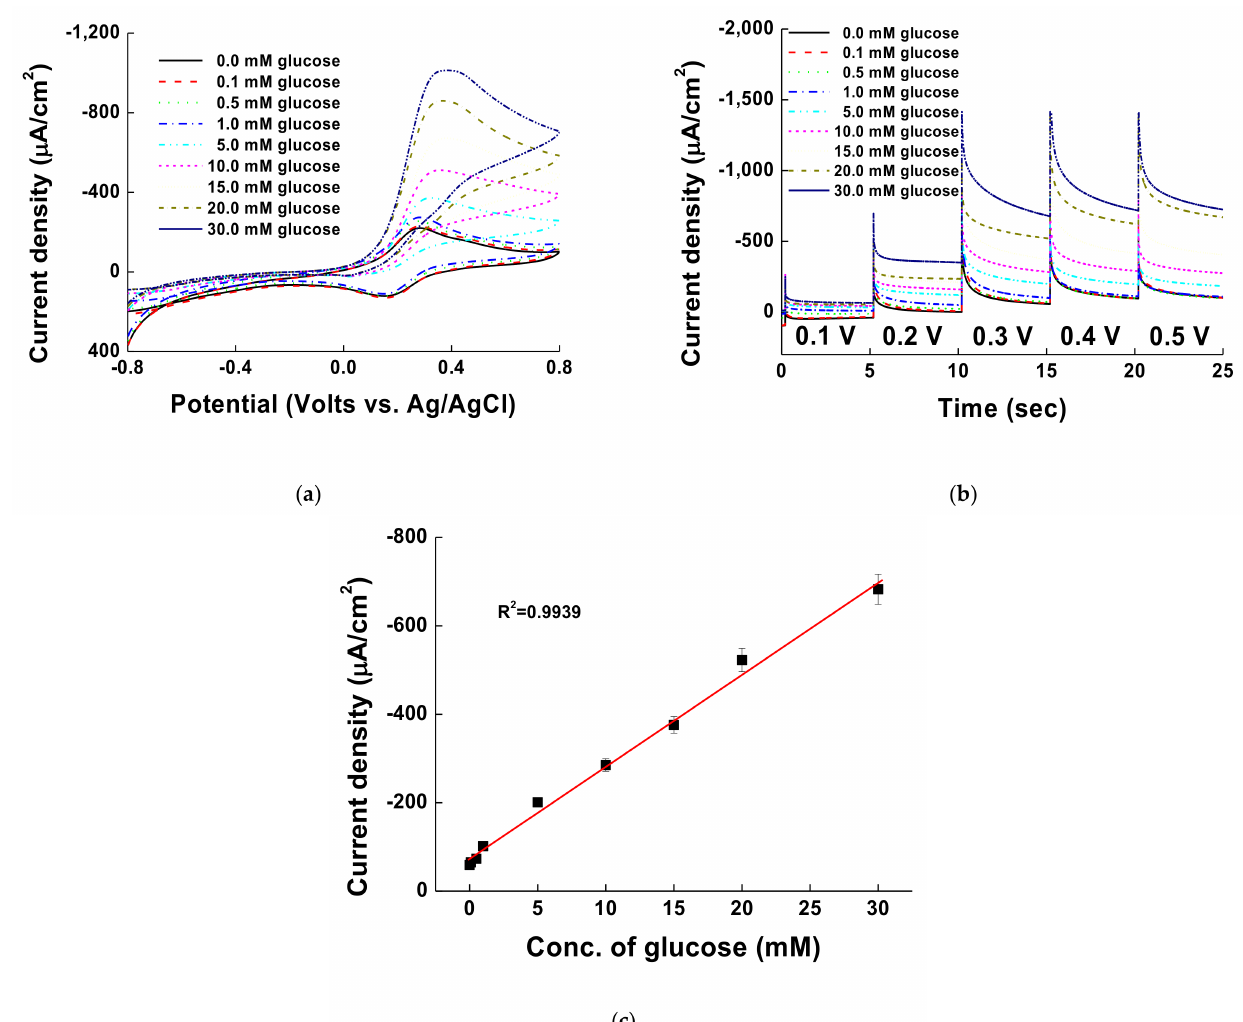
Figure 5. ( a ) Cyclic voltammograms and ( b ) multi-potential step (MPS) results of measuring glucose at concentrations of 0.0, 0.1, 0.5, 1.0, 5.0, 10.0, 15.0, 20.0, and 30.0 mM in PBS (pH 7.0). ( c ) Calibration curve of glucose concentration from 0.0 to 30.0 mM at 0.3 V of MPS in ( b